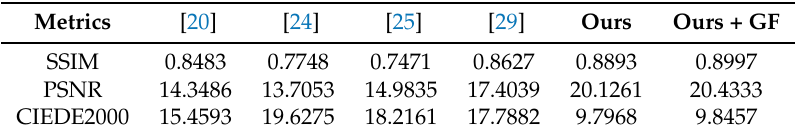
Table 2. Quantitative results on synthetic underwater images in terms of SSIM, PSNR and CIEDE2000.